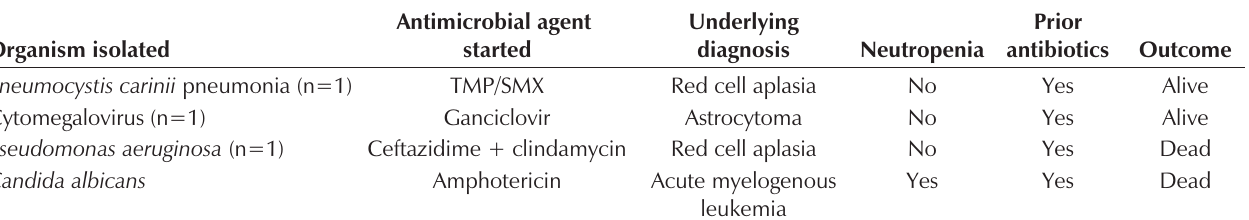
Nonbone marrow transplant recipients whose antimicrobial therapy was changed postbronchoalveolar lavage (n=4) Organism isolated